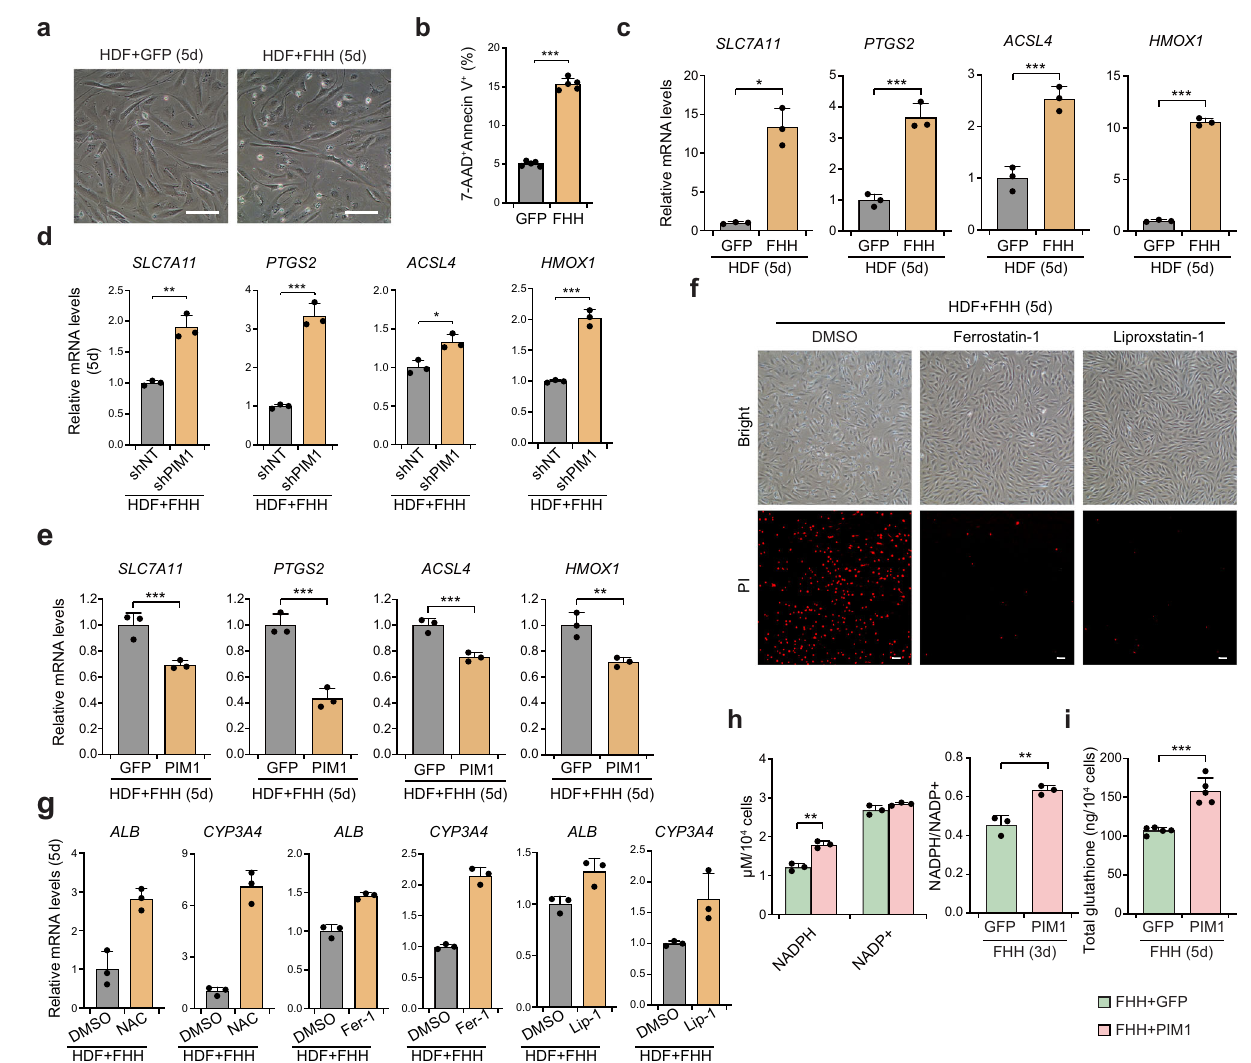
Fig. 6 | PIM1 suppresses hepatic reprogramming-induced ferroptosis. a Representative image of FHH-induced cell death of HDFs on day 5. Scale bars = 100 μ m. n = 4 biological replicates. b FHH-induced cell death was analyzed by Annexin V/7-AAD staining on day 5. Proportions of 7-AAD/Annexin V positive cells were quanti fi ed ( p <0.0001, n = 5). c Expressionlevels of ferroptosis-related genes wereincreasedonday5ofhepatictransdifferentiation( SLC7A11p =0.0009, PTGS2 p = 0.0007, ACSL4 p = 0.0013, HMOX1 p <0.0001, n = 3). d Knockdown of PIM1 increased the transcript levels of ferroptosis genes on day 5 of hepatic transdif- ferentiation ( SLC7A11 p = 0.0015, PTGS2 p = 0.0002, ACSL4 p = 0.0121, HMOX1 p = 0.0002, n = 3). e Overexpressio n of PIM1 decreased the transcript levels of fer- roptosisgeneson day5of hepatic transdifferentiation ( SLC7A11 p = 0.0062, PTGS2 p =0.0011, ACSL4p =0.0025, HMOX1p =0.0080, n =3).Thesampleswerethesame